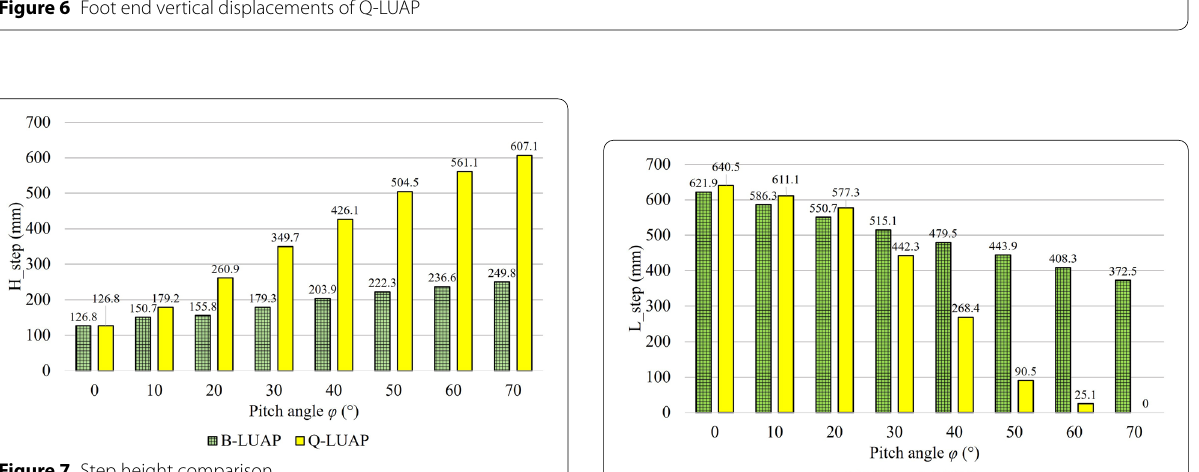
Figure 7 Step height comparison